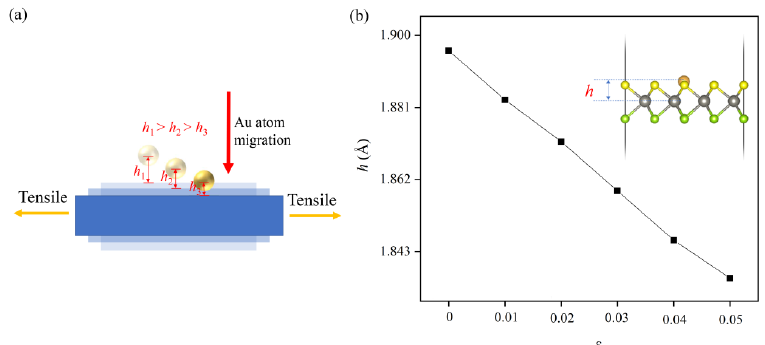
Figure 3. ( a ) The diagram of single Au atom position change over external tensile stress. ( b ) The height of the single Au atom from the W plane in Au/WSSe under different tensile strain.